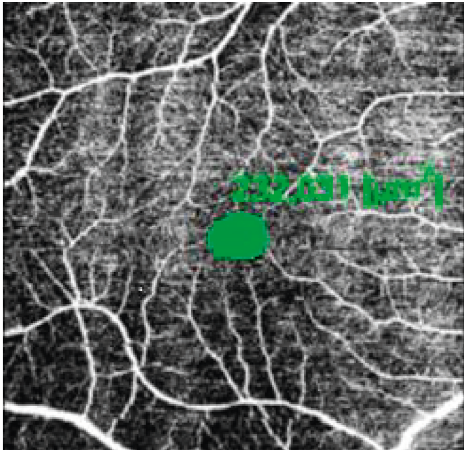
Figure 2: The fovea avascular zone (FAZ) area has been manually plotted using the polygon selection tool in the superficial capillary plexus (SCP) and its dimension is reported in square micrometers. The end tip vessels at SCP were manually marked and these areas were connected and the area of the central area was calculated by the